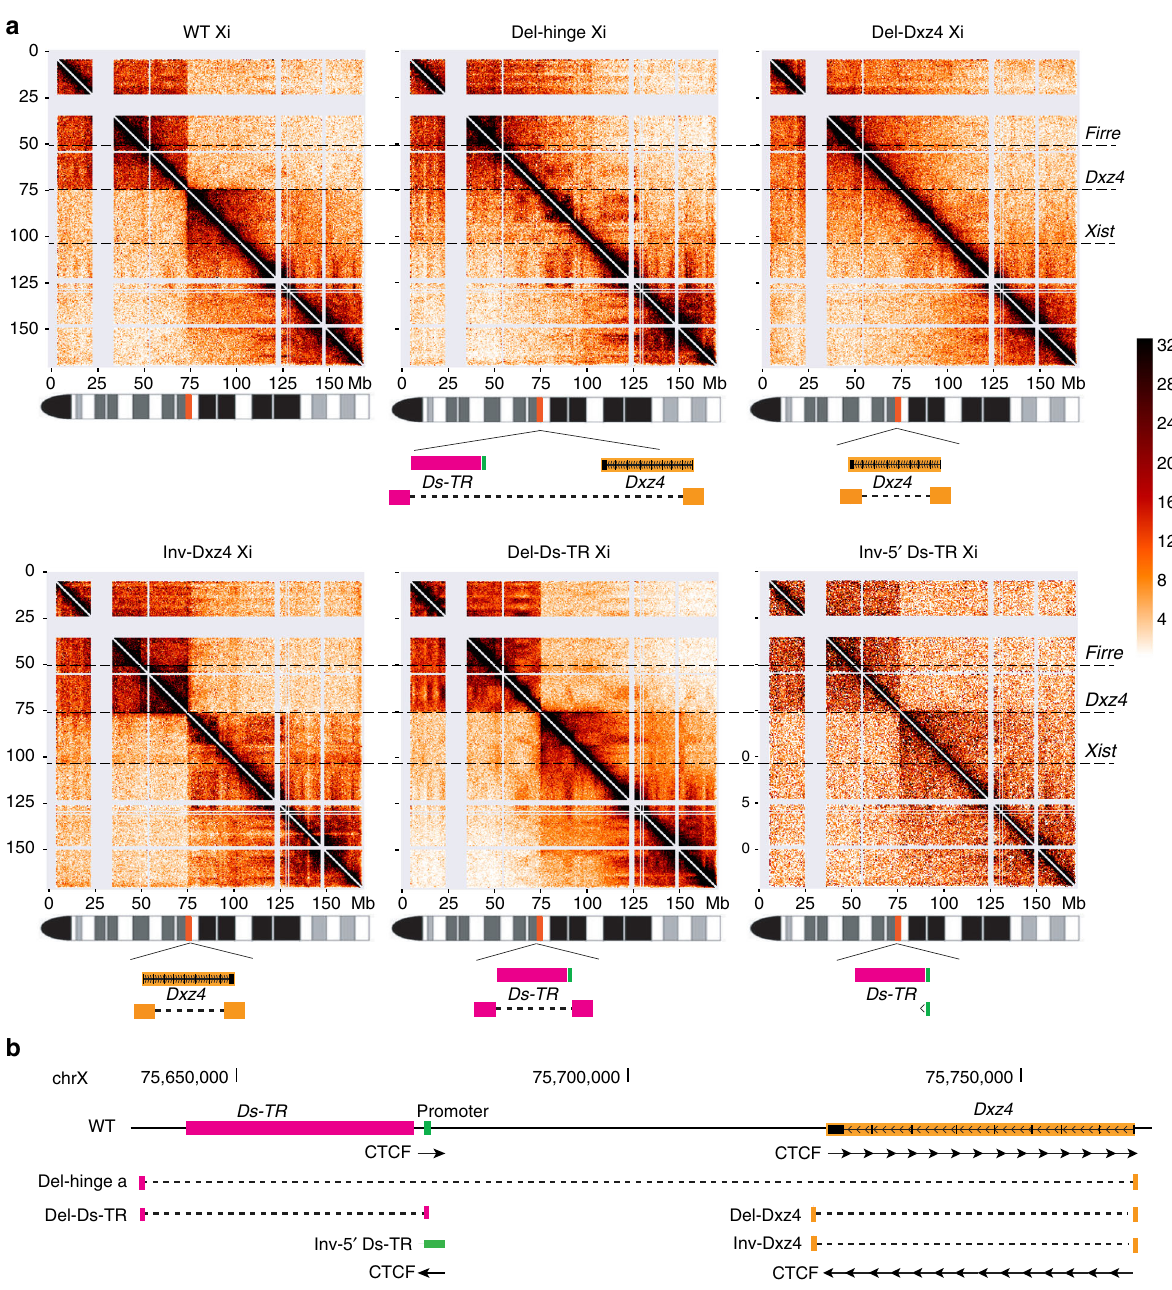
Fig. 1 Dxz4 alone is necessary to maintain the bipartite structure of the Xi. a Hi-C contact maps are shown at 500 kb resolution for the Xi in WT, Del-hinge (Xi deletion nt75637519 – 75764753), Del-Dxz4 (Xi deletion nt75721096 – 75764754), Inv-Dxz4 (Xi inversion nt75721096 – 75764754), Del-Ds-TR (Xi deletion nt75637501 – 75674037), and Inv-5 ′ Ds-TR (Xi inversion nt75674046 – 75674952). Note that fewer reads were obtained for the Inv-5 ′ Ds-TR, resulting in lower resolution (Supplementary Table 1). Allelic reads are listed in Supplementary Data 1. The location of Dxz4 , Firre , and Xist , and schematics of the allele-speci fi c deletions/inversions are shown. The color scale shows normalized contact counts. See Supplementary Fig. 2a for contact maps of the Xa in the same cell lines. b Relative position of the loci within the hinge region and location of the CRISPR/Cas9-induced alterations. Arrows indicate the orientation of CTCF motifs at Dxz4 12 and at the 5 ′ end of Ds-TR . See Supplementary Fig. 5b for CTCF binding at Dxz4 on the Xi by Strong differences in the contact decay curves (average contact locus results in even stronger insulation between superdomains counts as a function of distance) are evident for particular regions than in its WT orientation (Fig. 2f). In the Firre - Dxz4 region of the Xi between the different cell lines (Fig. 2e – h). Within the (~25 Mb) both Dxz4 -edited cell lines display a high proportion of Firre - Xist region (~53 Mb), Del-hinge/Dxz4 shows a high long-range contacts (10 – 20 Mb), with Inv-Dxz4 showing the proportion of very long-range interactions (>20 Mb), resulting highest proportion of very long-range contacts, re fl ecting in an Xa-like pro fi le due to loss of insulation between increased contacts between Dxz4 and Firre (Fig. 2g). In the superdomains, while Inv-Dxz4 makes even fewer very long- Dxz4 - Xist region (~28 Mb) there is a dramatic loss in long-range range interactions than WT*, implying that the inverted Dxz4 contacts in both Del-hinge/Dxz4 and Inv-Dxz4 (Fig. 2h). Note